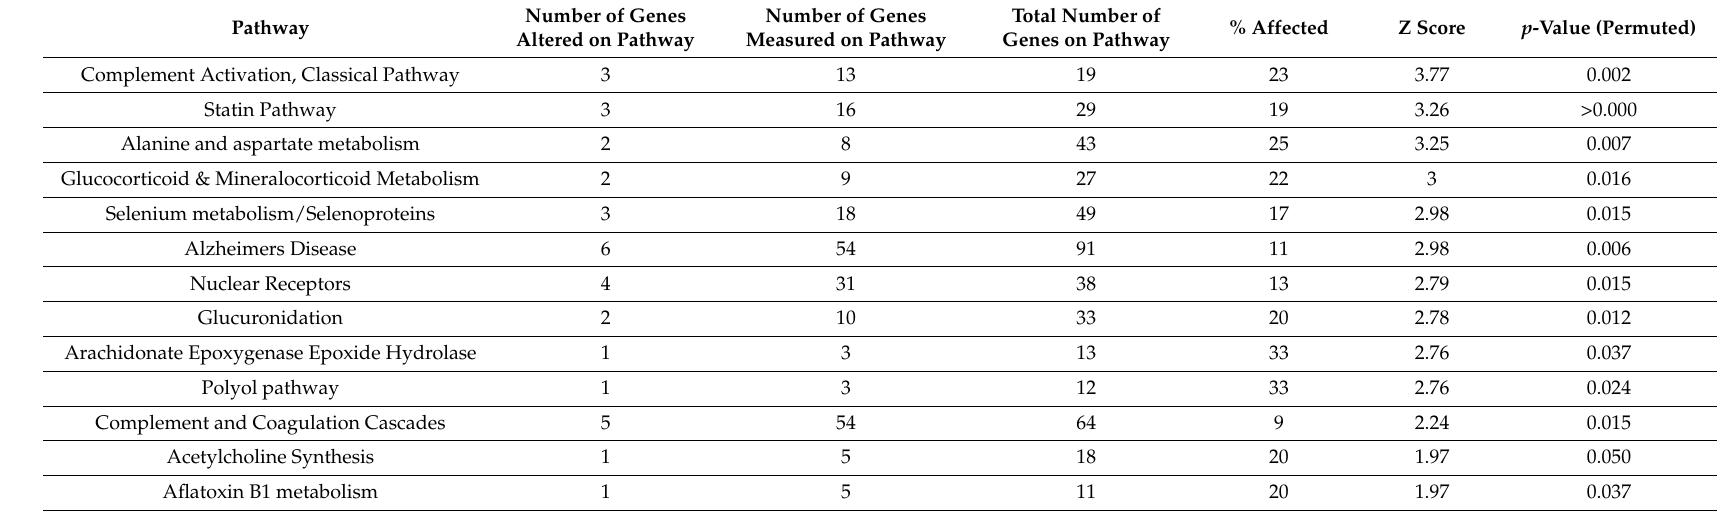
Aflatoxin B1 metabolism 1 5